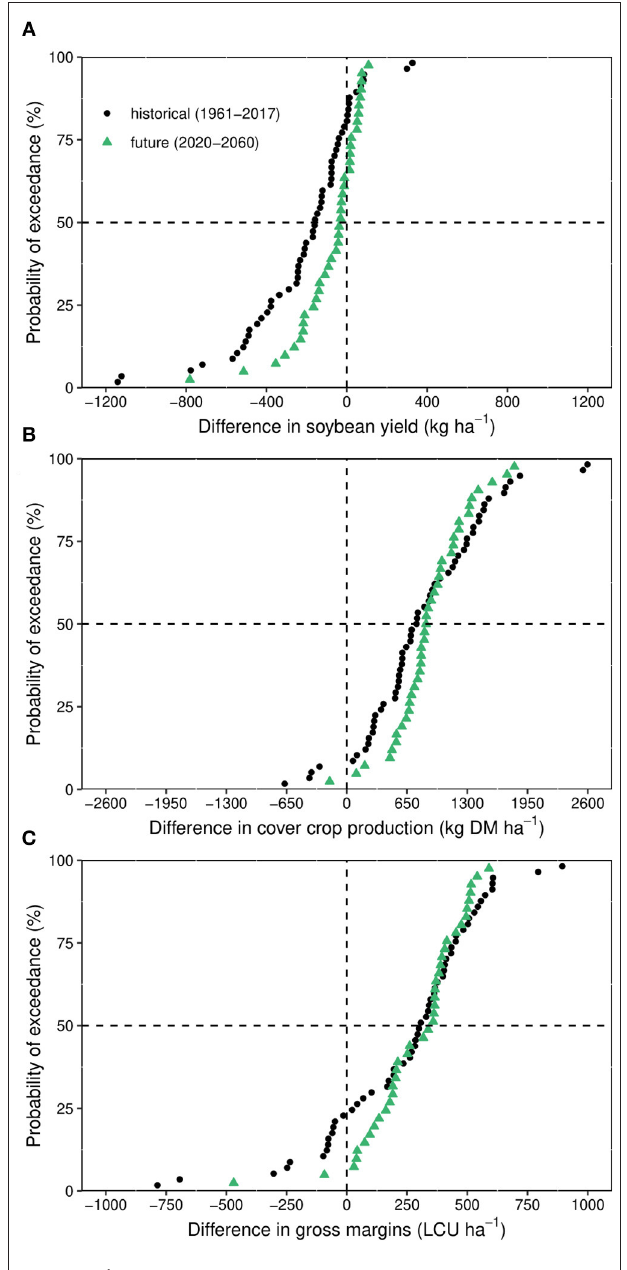
FIGURE 2 | Simulated difference in productivity indicators in the integrated system (grazed cover crop) compared with the specialized control (ungrazed cover crop). Values for the specialized system are set at 0, with points representing relative productive penalty or benefit for each simulated year in the integrated system. Productivity indicators are (A) soybean yield, (B) ryegrass cover crop aboveground biomass production, and (C) gross margins under historical (black points) or future (green triangles) climate